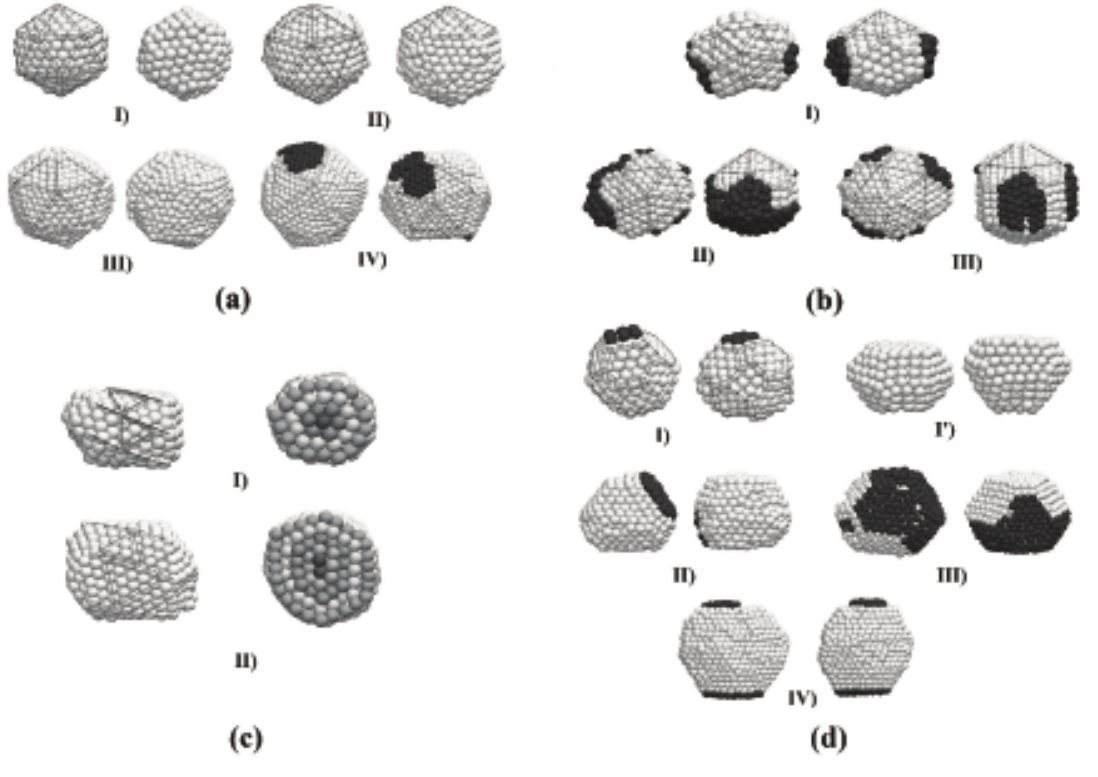
Figure 4. Final structures obtained through the self-assembling of two gold clusters, shown at two different orientations. ( a ) Icosahedral kind (Ih) structures of order 4, 5, 6, and 7; ( b ) Stellated Marks decahedra (m-Dh), surrounded by atoms (dark color) along the (100) planes; ( c ) Helical particles made of coaxial shells (different colors have been used to emphasize the shells structure); ( d ) Truncated octahedral-like (TO)